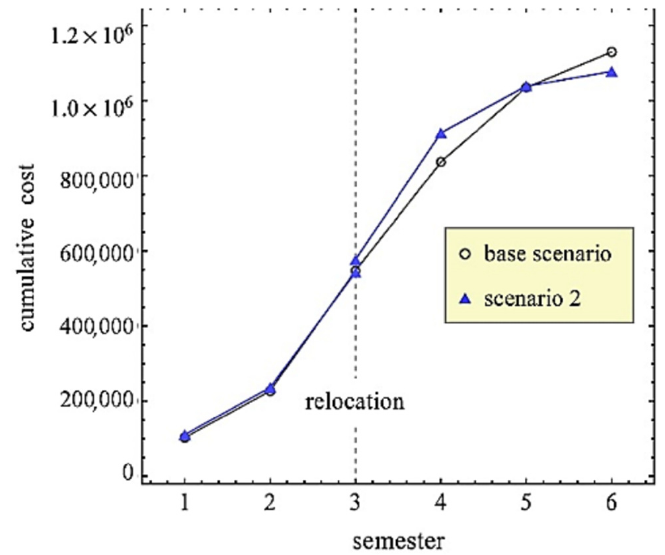
Figure 4. Comparison of cumulative costs.